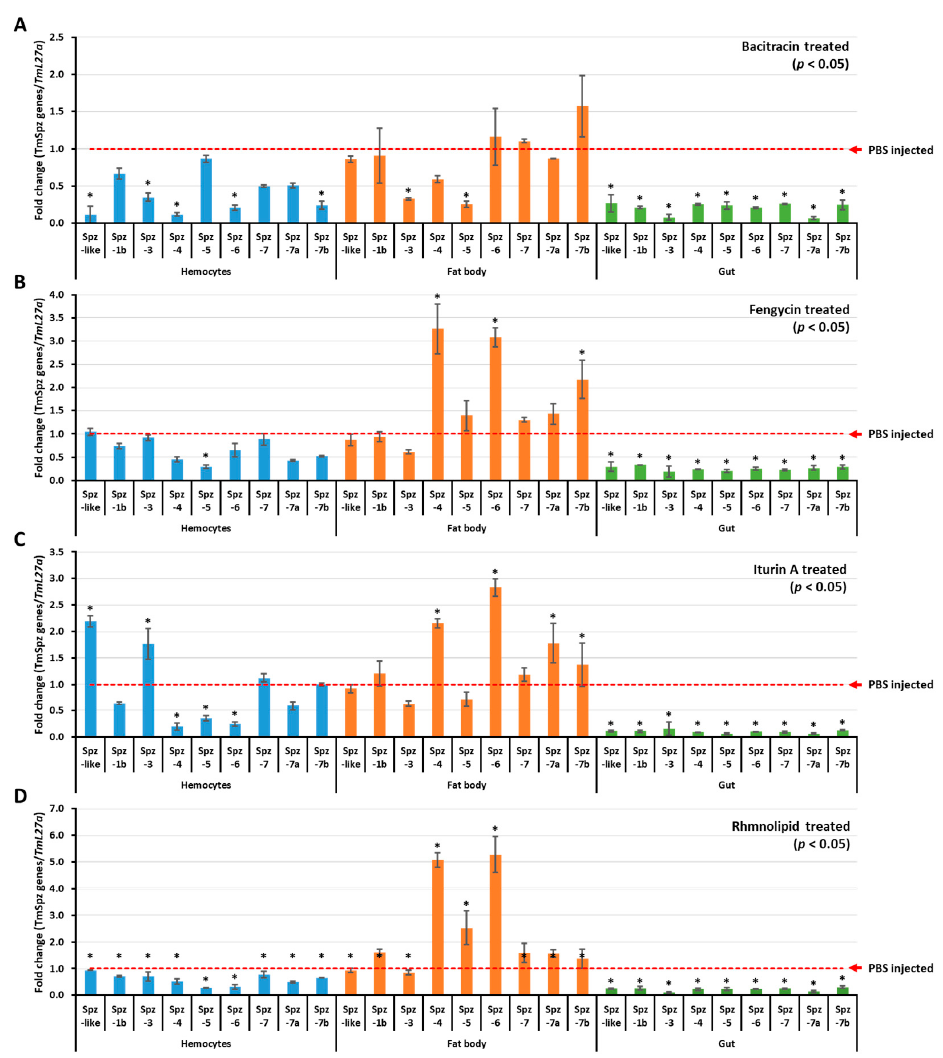
Figure 4. TmSpzs induction patterns in different tissues. The expressions of Spatzles gene in different tissues were examined by injecting either bacitracin ( A ), fengycin ( B ), iturin A ( C ), or rhamnolipid ( D ). Twenty-four hours post biosurfactant injection, three tissues—hemocytes, fat bodies, and gut—were dissected. The expression of spätzle in each tissue was quantified by qRT-PCR using specific primers. The data are the average of three replicates. * significant difference ( p < 0.05) of Spatzles expression, compared to the PBS-injected group.